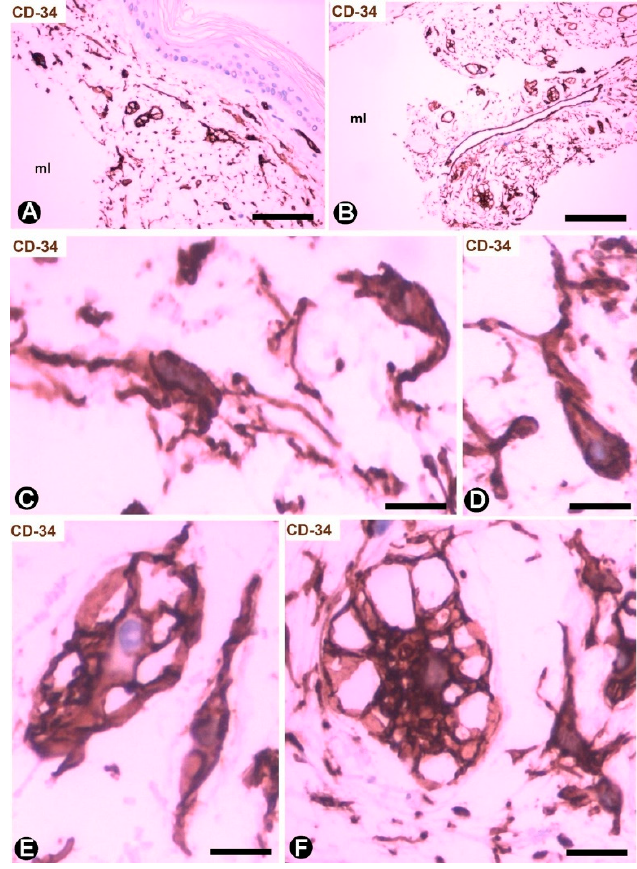
Figure 5. CD34+SCs/TCs in cutaneous myxoid cyst. CD34 immunochemistry; hematoxylin counter- stain. ( A , B ) TCs/CD34+SCs are present in loose connective tissue of the dermis with myxoid lagoons (ml). ( C , D ) A spindle-shaped, stellate, pyriform or irregular morphology is observed in many of these cells. ( E , F ) Presence of bulky and multi-vacuolated CD34+ mononuclear cells in the myxoid areas. Bar: ( A , B ) 80 µm, ( C – F ) 15 µm.